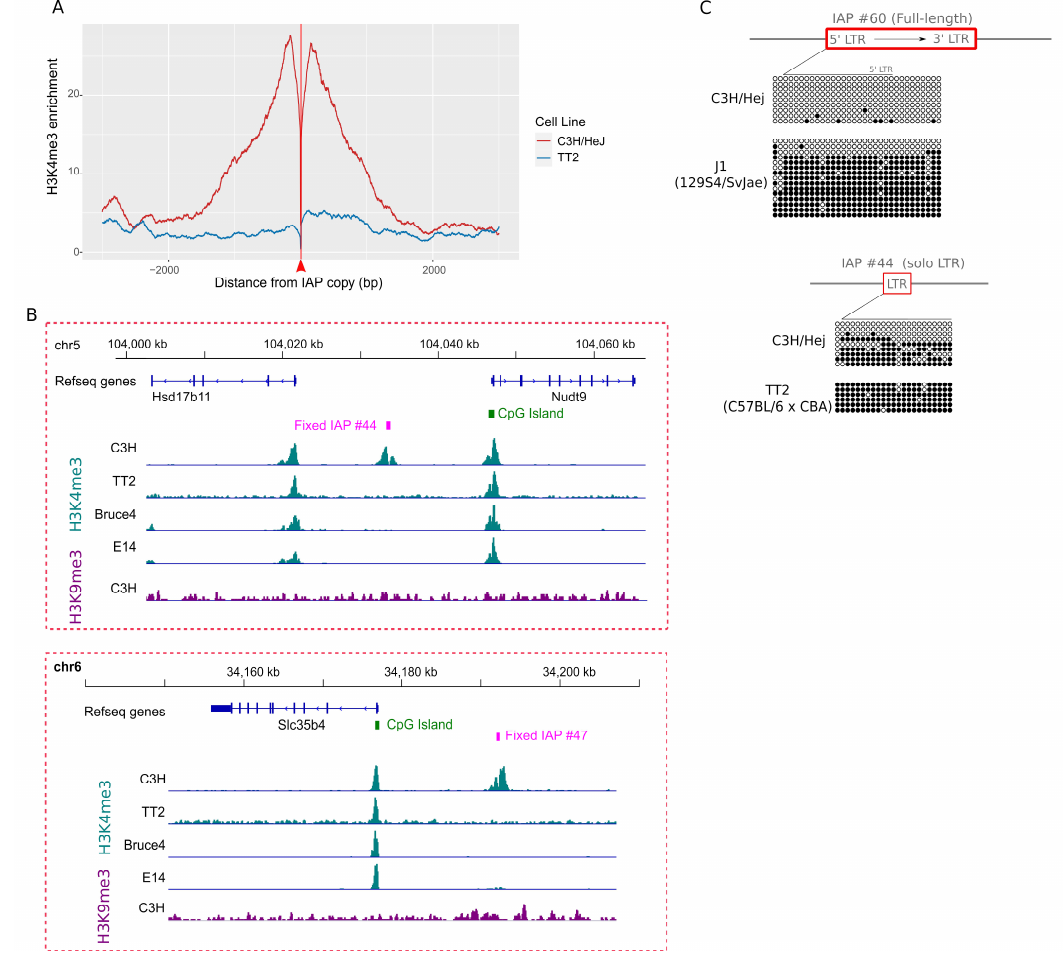
Figure 5. ( A ) Average profile of H3K4me3 at the flanking sites of 29 IAP copies common to C3H/HeJ, 129 and C57BL/6 in C3H/HeJ and TT2 ES cells. The red arrow and line represents IAP insertion site.